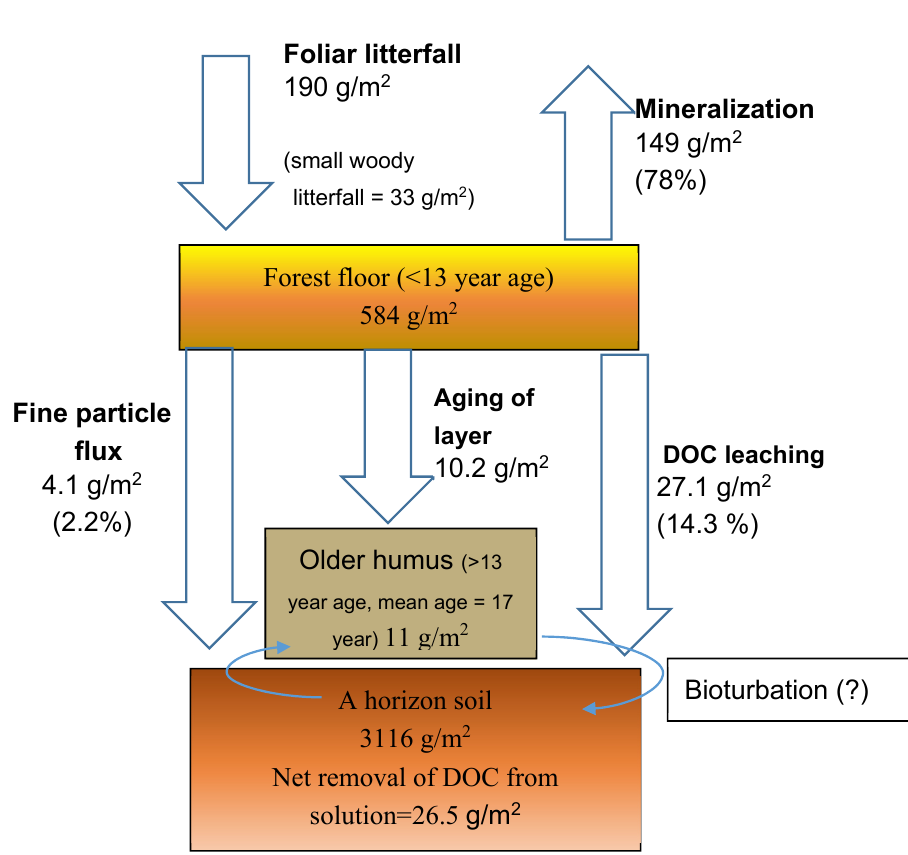
Figure 2. The fate of litterfall carbon in the South facing deciduous forest floor. Standing stocks and fluxes are shown as g C/m 2 (per year). In parenthesis, the fluxes are shown as a percentage of litterfall rate. All fluxes and stocks are for foliar litterfall, except that small woody litterfall is also indicated separately. Mineralization was estimated by the balance of all other fluxes. The arrow from the forest floor (0–13 years) to the “Older humus” represents the mass of the layer of the 13th year being transferred to the “older than 13 years humus”. The net DOC (dissolved organic C) leaching flux is taken from Qualls et al. [38] which was done on the same watershed. The net DOC leaching flux was calculated as the flux from the forest floor minus DOC flux in throughfall so as to represent the net amount of C originating from the forest floor. Bioturbation of C between the forest floor and the A horizon was not quantified in the study and so is shown as a question mark. Soil C in the A horizon for the South facing deciduous WS is cited from Swank at al. [40] and the net removal of DOC from solution flowing through the A horizon is from Qualls et al. [41] but it includes some portion originating from throughfall.